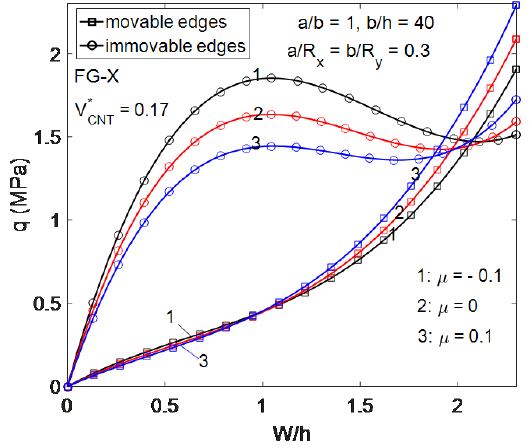
Fig. 10: Effects of geometrical imperfection on the nonlinear re- sponse of FG-CNTRC spherical panels under uniform external pres- sure.